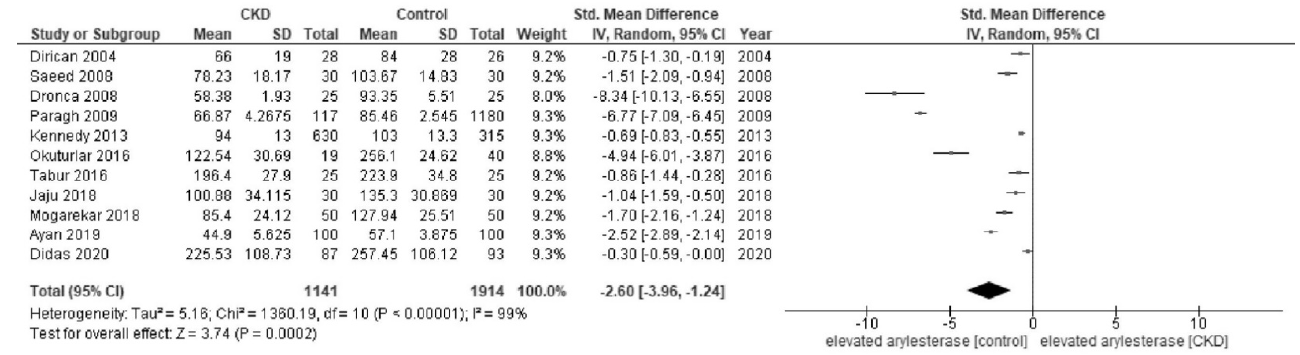
Figure 3. Forest plot of arylesterase activity in all studies [28,30,32,34,39,41–43,45–47].